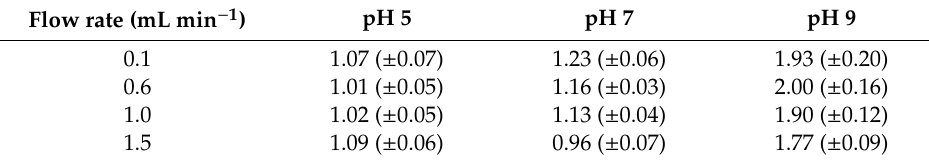
Table 1. Apparent Hill coe ffi cients ( n app ) vs. pH at di ff erent flow